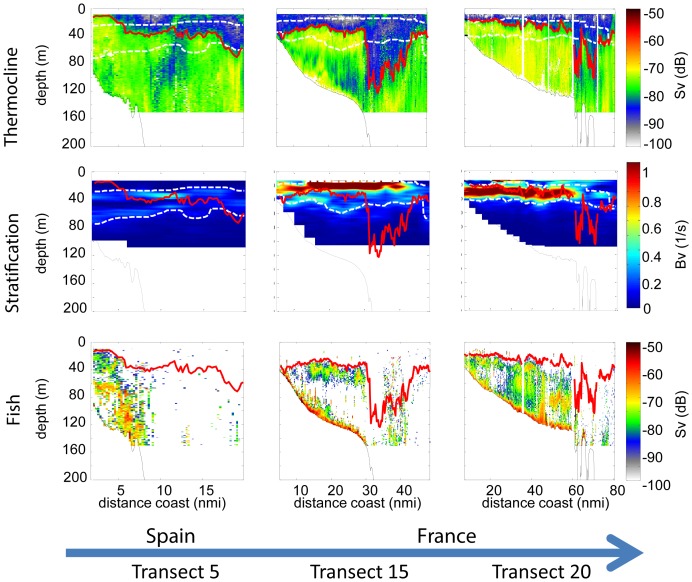
Along transect fine scale distribution of hydrological and biological parameters.Representation of backscattering strength (Sv in dB re. 1 m−1), stratification and fish acoustic backscattering in relation to the biocline pattern (red solid line) during the survey period (transect 5, 15 and 20). The upper and lower limits of the thermocline layer are represented by white dotted line.